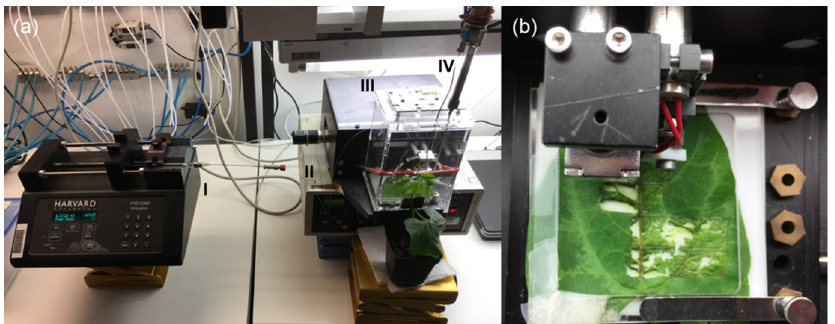
Figure 2. Volatile collection with SpitWorm. ( a ) MecWorm/SpitWorm. (I) Automatic syringe pump with a 100 μ L syringe; (II) capillary for OS delivery; (III) plexiglas case; (IV) volatile collector. ( b ) Close-up of the biting head of SpitWorm punching a lima bean leaf. For MecWorm treatment, the capillary was removed and for larval treatment, the system was switched off.